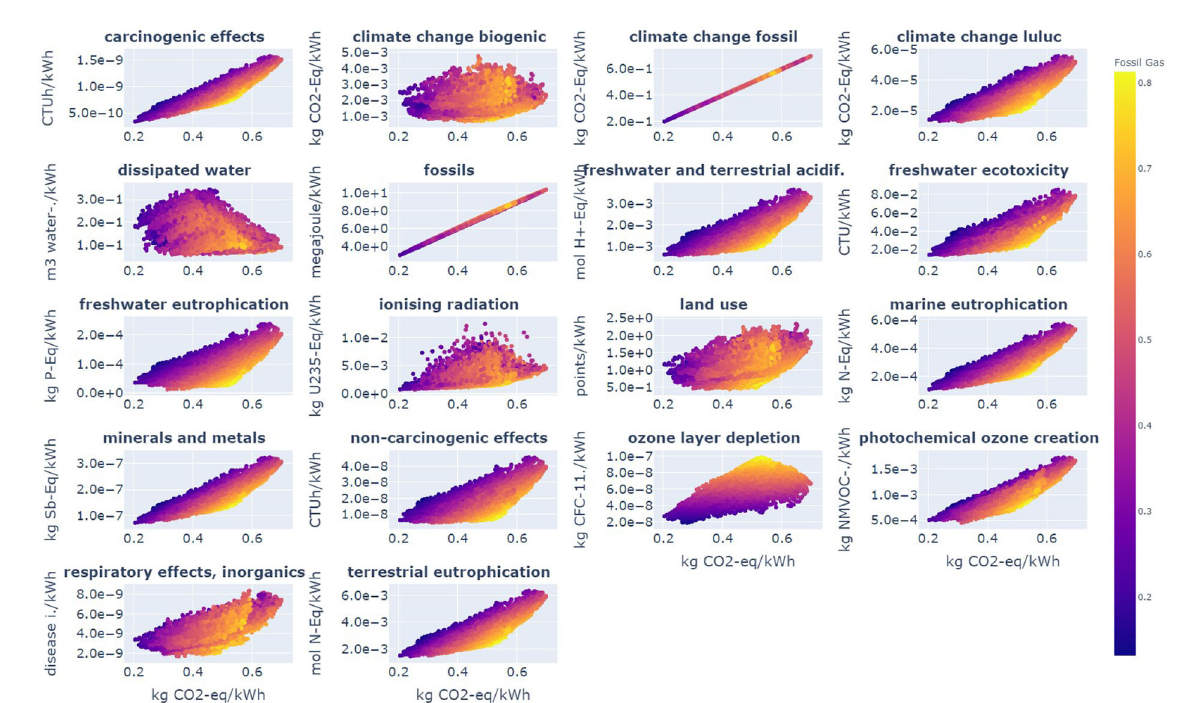
FIGURE4 Scatter plots correlating the hourly impacts per kWh of electricity for Climate change total indicator ( x -axis) and the remaining 18 impact indicators. The graphs cover the full dataset, from 1 January 2016 to 15 September 2019. The gradient from purple to yellow signals an increasing share of fossil natural gas in the electricity mix, from 10% to 80%. LULUC, Land Use and Land Use